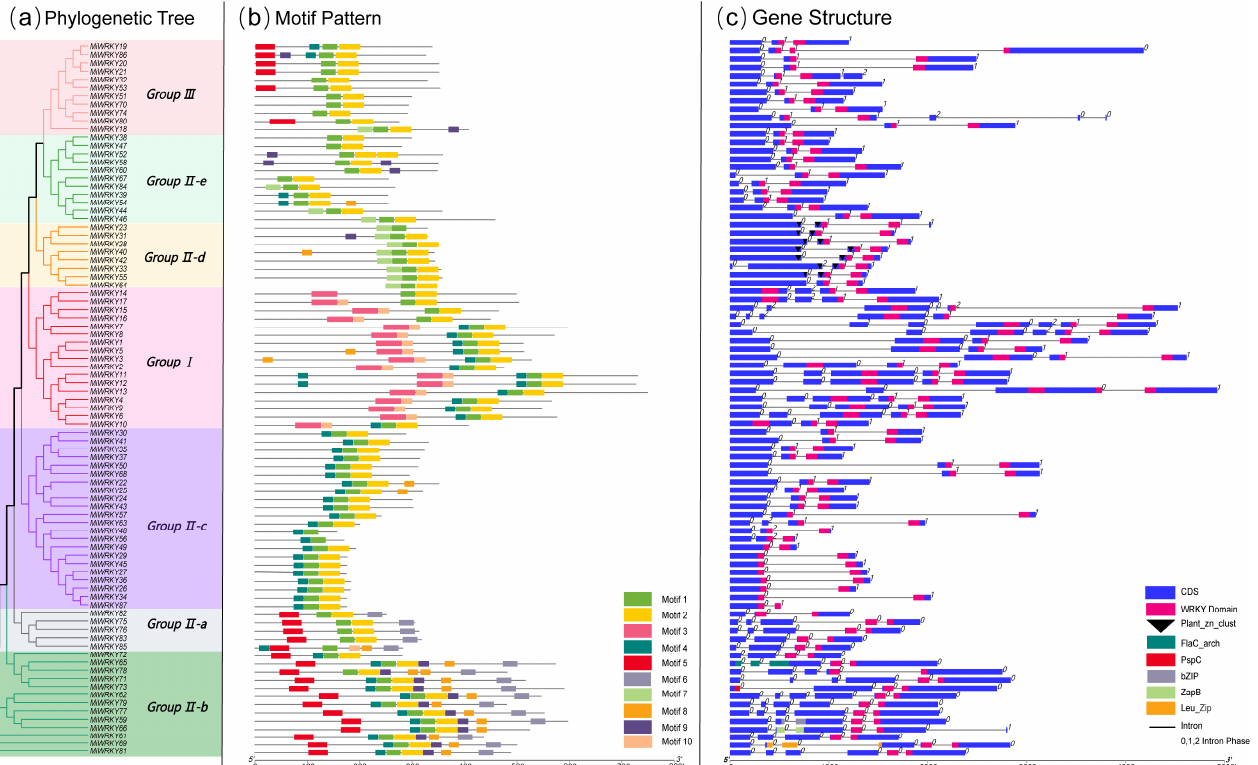
Figure 3. Phylogenetic relationships, motif pattern, and gene structure in WRKY genes from the mango. ( a ) Using MEGA-X software, a phylogenetic tree was built according to the full-length sequences of mango WRKY proteins. Different colors were used to show the different clusters. ( b ) Mango WRKY protein motif composition. Motifs numbered from 1 to 10 were exhibited with differently colored boxes. Sequence information for each subject is supplied in Supplementary File S4. The scales were used for protein length estimation. ( c ) Gene structure of mango WRKYs . Blue boxes indicated coding sequences (CDS); black lines indicated introns. The WRKY domains are shown by red boxes. The numbers show the phases of the corresponding introns.